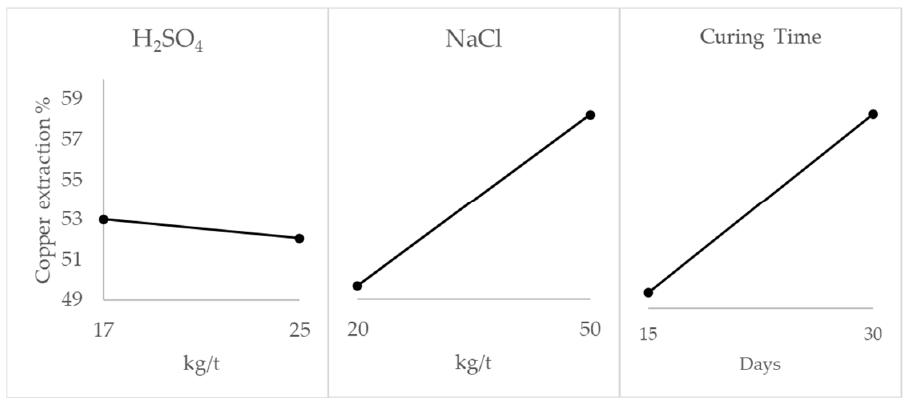
Figure 3. Effect of variables sulfuric acid, sodium chloride, and pretreatment time on pretreatment stage (test A).